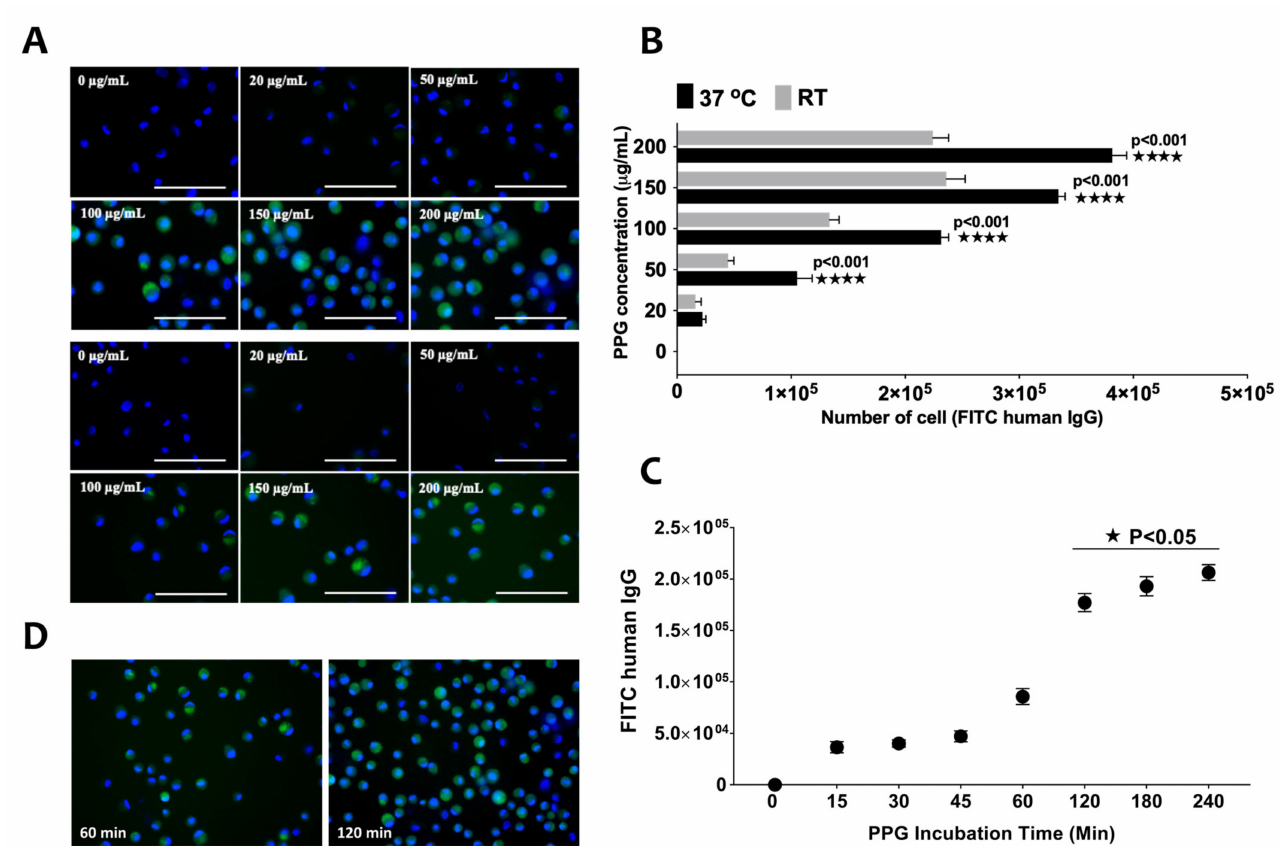
Figure 2. The effect of temperature and PPG concentration on the intercalation of PPG on MSCs. ( A ) The images show fluorescence staining of MSCs at each concentration of PPG. ( B ) The bar graph shows the fluorescence intensity of FITC- human IgG at 37 ◦ C and room temperature with different PPG concentration. ( C ) The micrograph indicates the MSCs stained with FITC-human IgG at 60 and 120 min. ( D ) The graph shows the different incubation times on PPG concentrations. Scale bars indicate 100 µ m (* p < 0.05, **** p < 0.001). The MSCs were counterstained with Hoechst staining